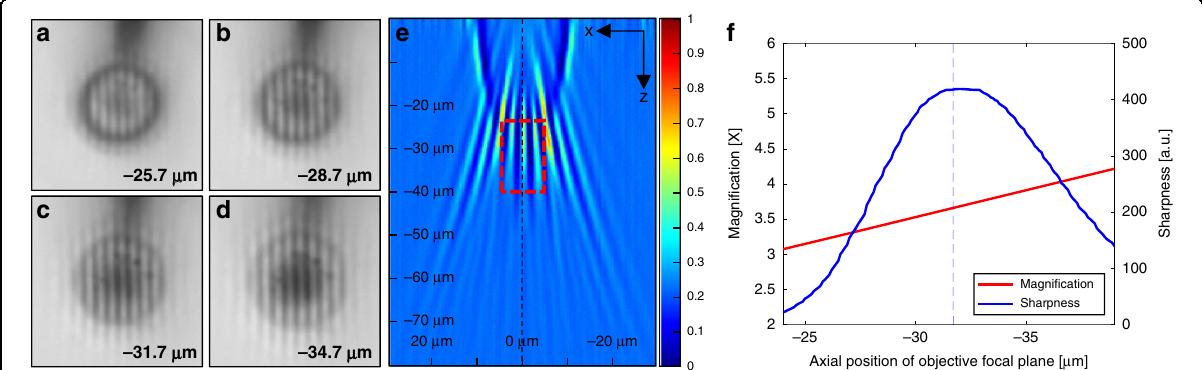
Fig. 4 Image stack of standard grating patterns, consisting of a 0.35- μ m line width and 0.7- μ m pitch, gathered by the MASR system with a ×20 objective lens to experimentally verify the axial position of the virtual image Z v and the magni fi cation M . SLG microsphere with a radius of 12 μ m was used. Images at different vertical positions (negative sign indicates a lower position from the sample): z : a − 25.7 μ m, b − 28.7 μ m, c − 31.7 μ m, and d − 34.7 μ m are shown. e x – z projection image of the image stack with the background signal removed. For analyzing the optimal position of the virtual image with the highest contrast, the edge sharpness in a speci fi c region (red-dashed box) was calculated. f Variation in the image contrast (sharpness) and magni fi cation according to the axial position of the objective focal plane. The experimental magni fi cation was calculated by counting the number of pixels with the image processing software, where the scan position was de fi ned at the point of best image contrast. The experimental magni fi cation of the 12 µm radius SLG microsphere was ×3.61, and the axial position of the virtual image was − 31.7 μ m.